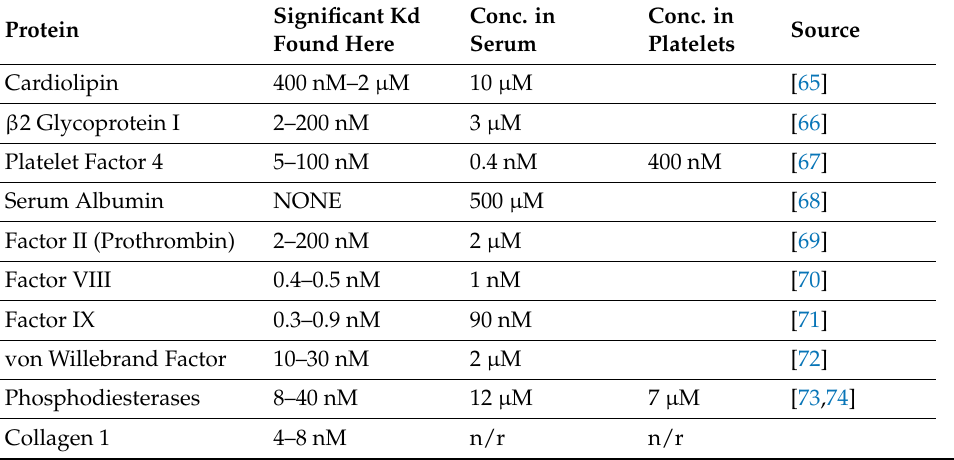
Table 2. The Kd range of antibodies found in experiments reported here compared with the serum or platelet concentration of the same proteins. In order for an antibody to bind up significant amounts of a protein to interfere with protein function or to create circulating immune complexes, the binding constant of the antibody must be smaller than or on the same order as the concentration of the protein in blood serum or within platelets. Conc = concentration; n/r = not relevant. Significant Kd Conc.